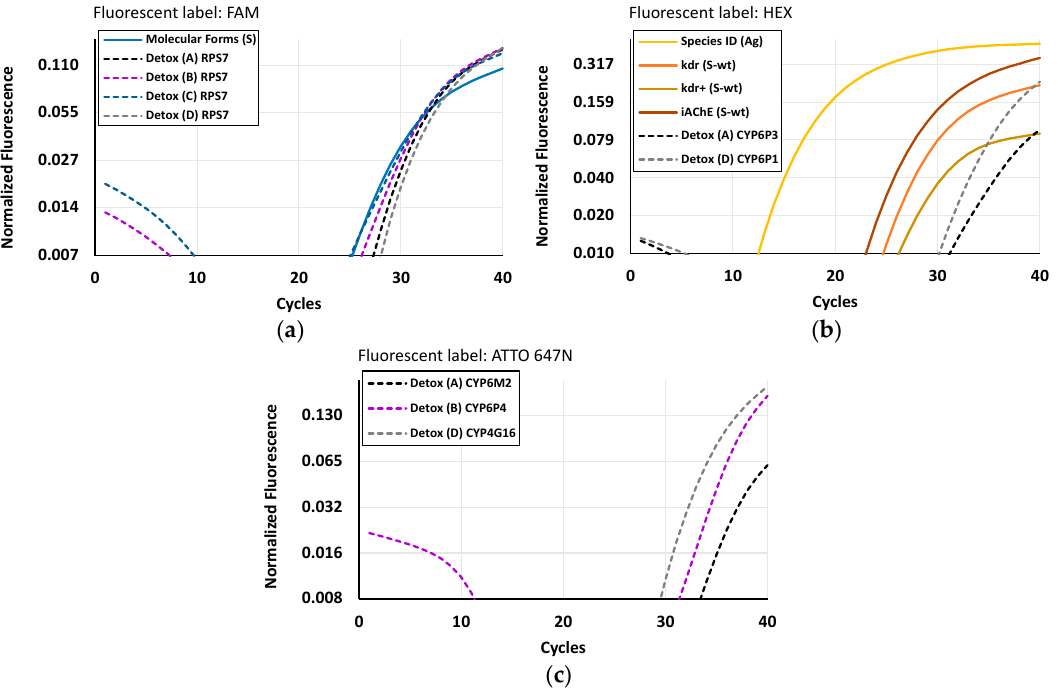
Figure 5. Indicative LabDisk real-time RT-PCR data acquired for the semi-quantitative analysis of mosquito samples in VectorDisk #D11, as one representative out of the 18 disks, from all three channels green ( a ), yellow ( b ), and red ( c ). DNA and RNA assays are shown in solid and dashed lines, respectively. The threshold was set to be the x -axis itself.